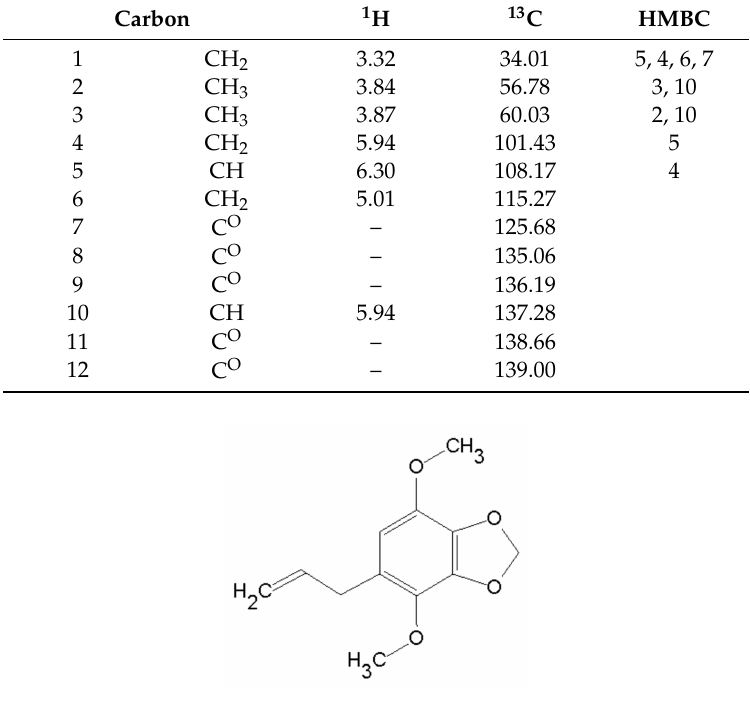
Figure 1. Apiole chemical